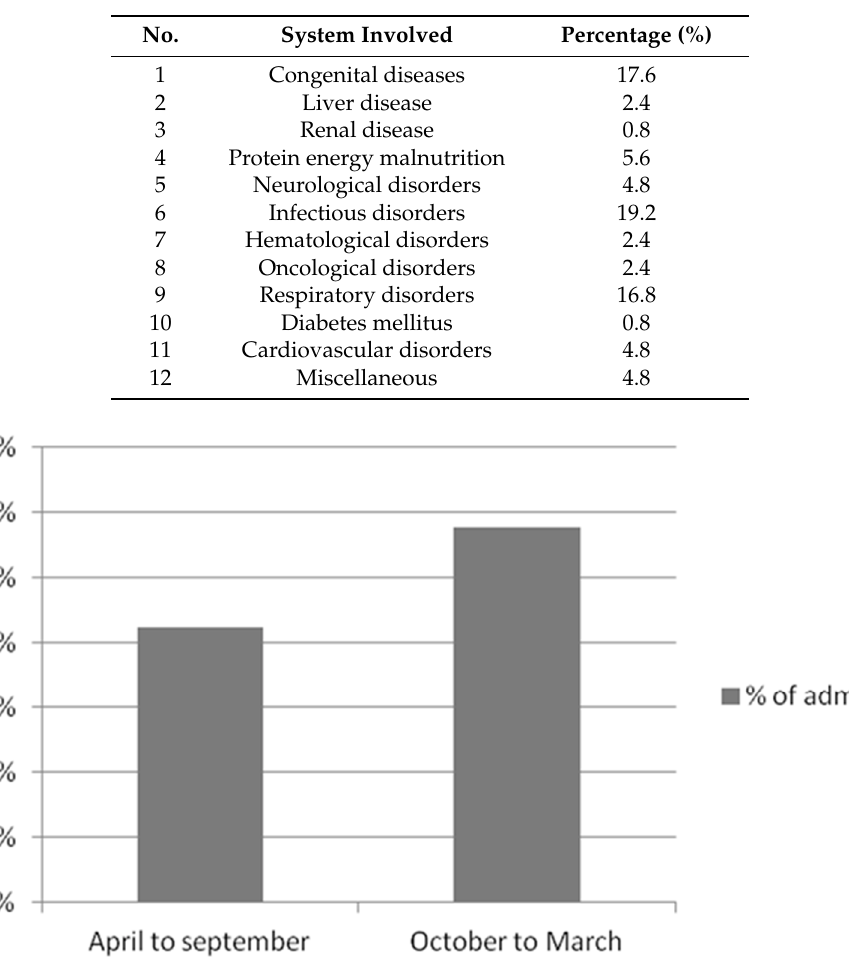
Table 2. Associated disorders involving different organ systems in children.